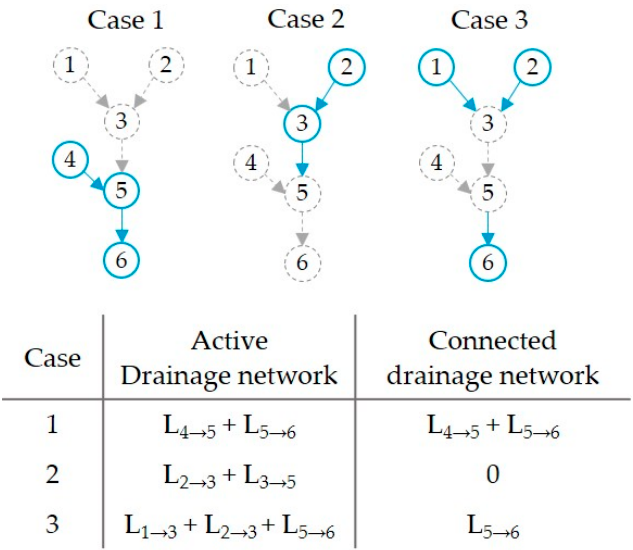
Figure 2. Metrics for the active drainage network and connected drainage network in three possible situations. Case 1, part of the river connects to the outlet. Case 2, there is flow in the channels, but it does not reach the outlet. Case 3, parts of the channels are disconnected. The numbered circles represent the overland-flow detectors. Continuous circles and arrows represent the OFDs and channels that had water. Dashed circles and arrows are the dry channels and OFDs for the respective case. The last circle represents the drainage outlet. The table shows the logic of the calculations. L is length.